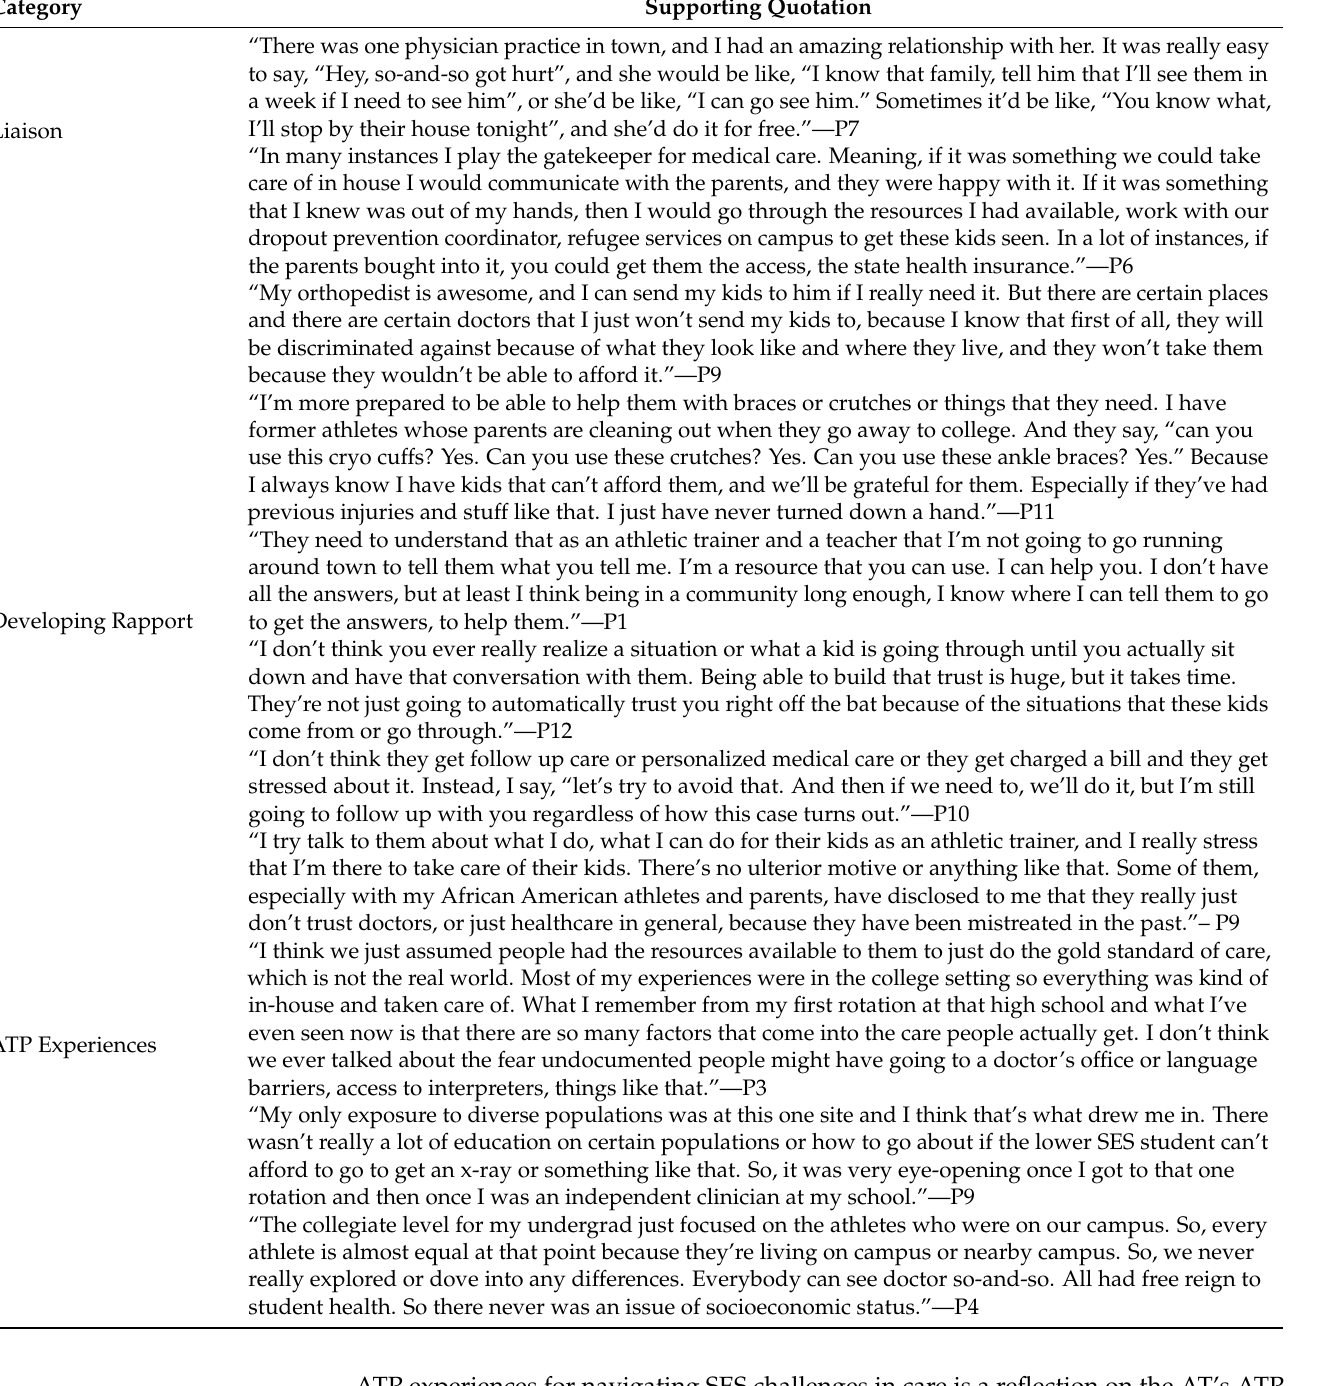
Table 5. Navigating Socioeconomic Status Challenges in